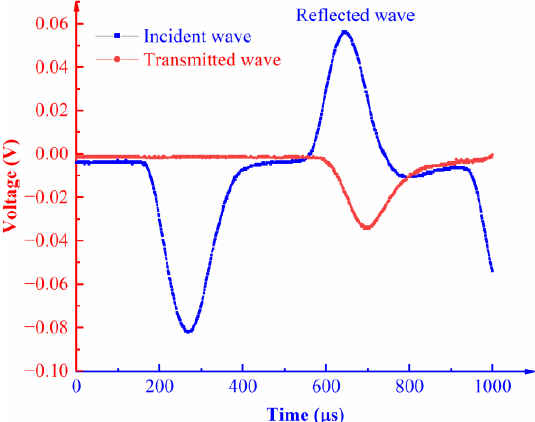
Figure 4. F-T scheme for the muddy siltstone specimen.